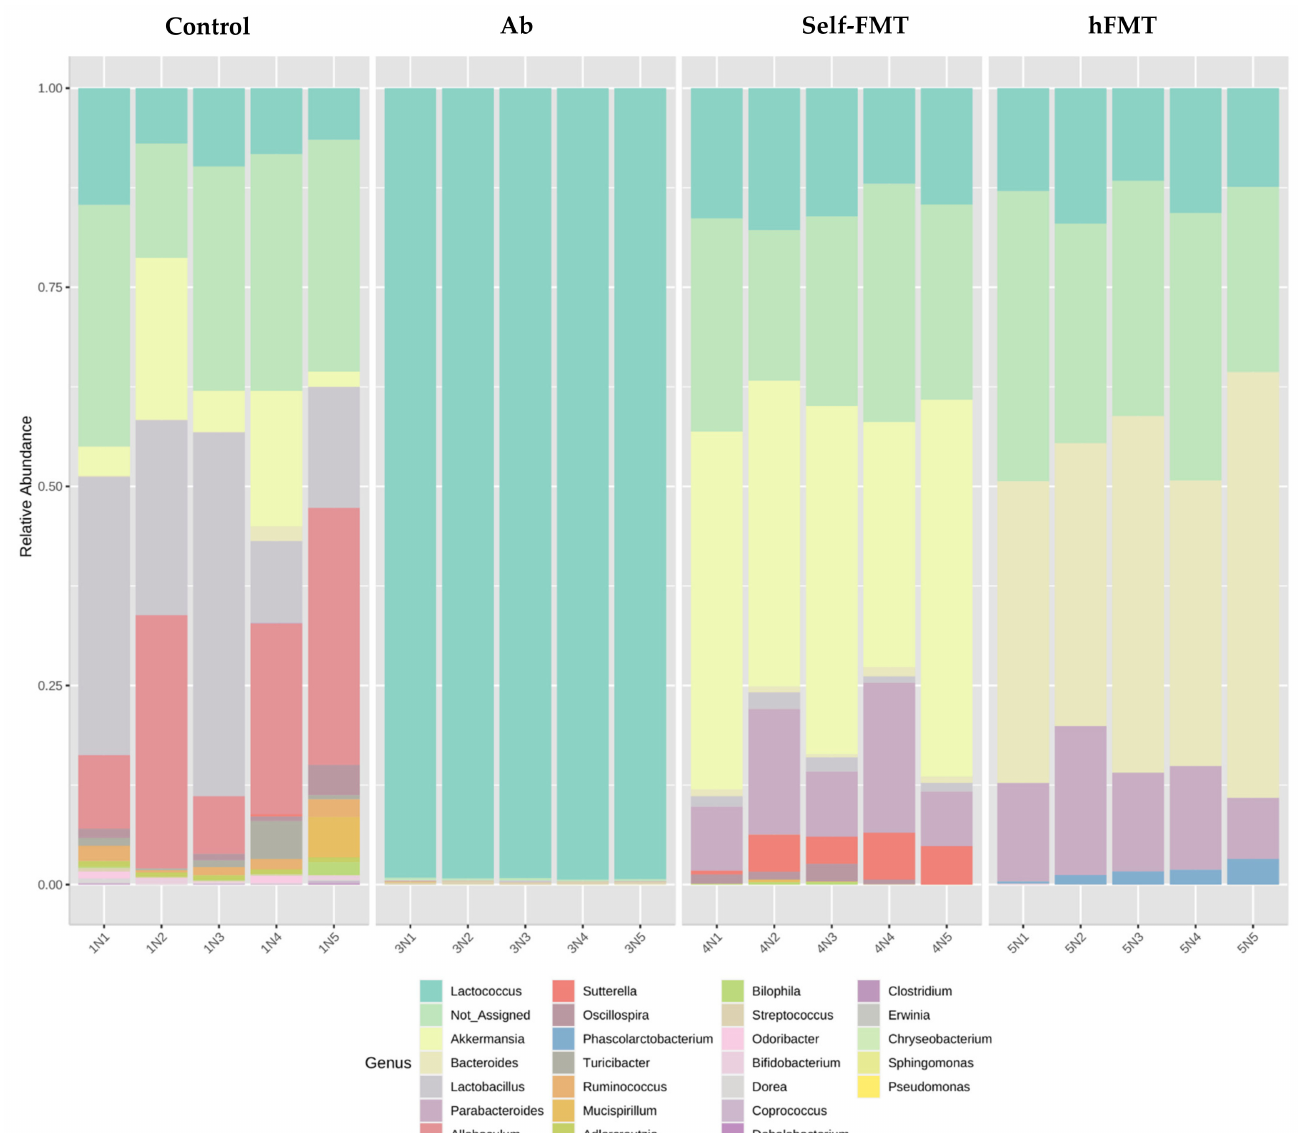
Figure 4. Changes in intestinal bacterial composition . Relative abundance of bacterial taxa (genus levels) found in the feces of the mice (n = 5) from the different treatment groups. Ab, antibiotic; hFMT, human fecal microbiota transplantation; self-FMT, self-fecal microbiota